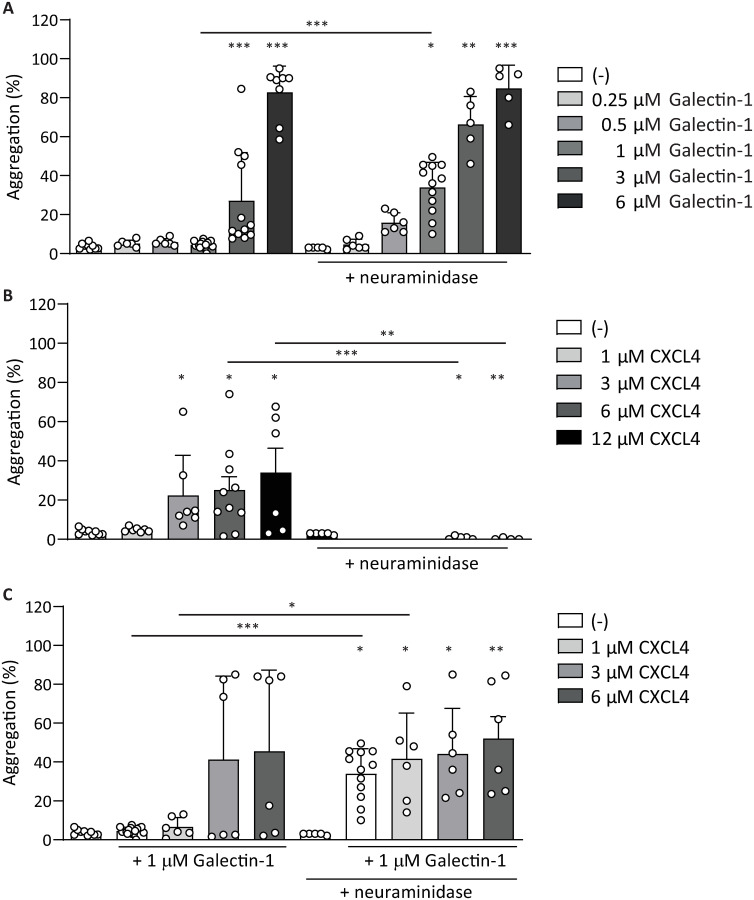
Neuraminidase-treatment causes platelet aggregation at lower galectin-1 concentrations.Platelet aggregation was induced in washed platelets by different concentrations of gal-1 (A), CXCL4 (B), or different concentrations of CXCL4 co-incubated with 1 μM gal-1 (C), with or without pretreatment with neuraminidase. Bars represent mean ± SD (n ≥ 3), *p < 0.05, **p < 0.01 as compared to vehicle within appropriate treatment with or without neuraminidase or conditions compared between treatments (Kruskal Wallis/Dunn’s test).